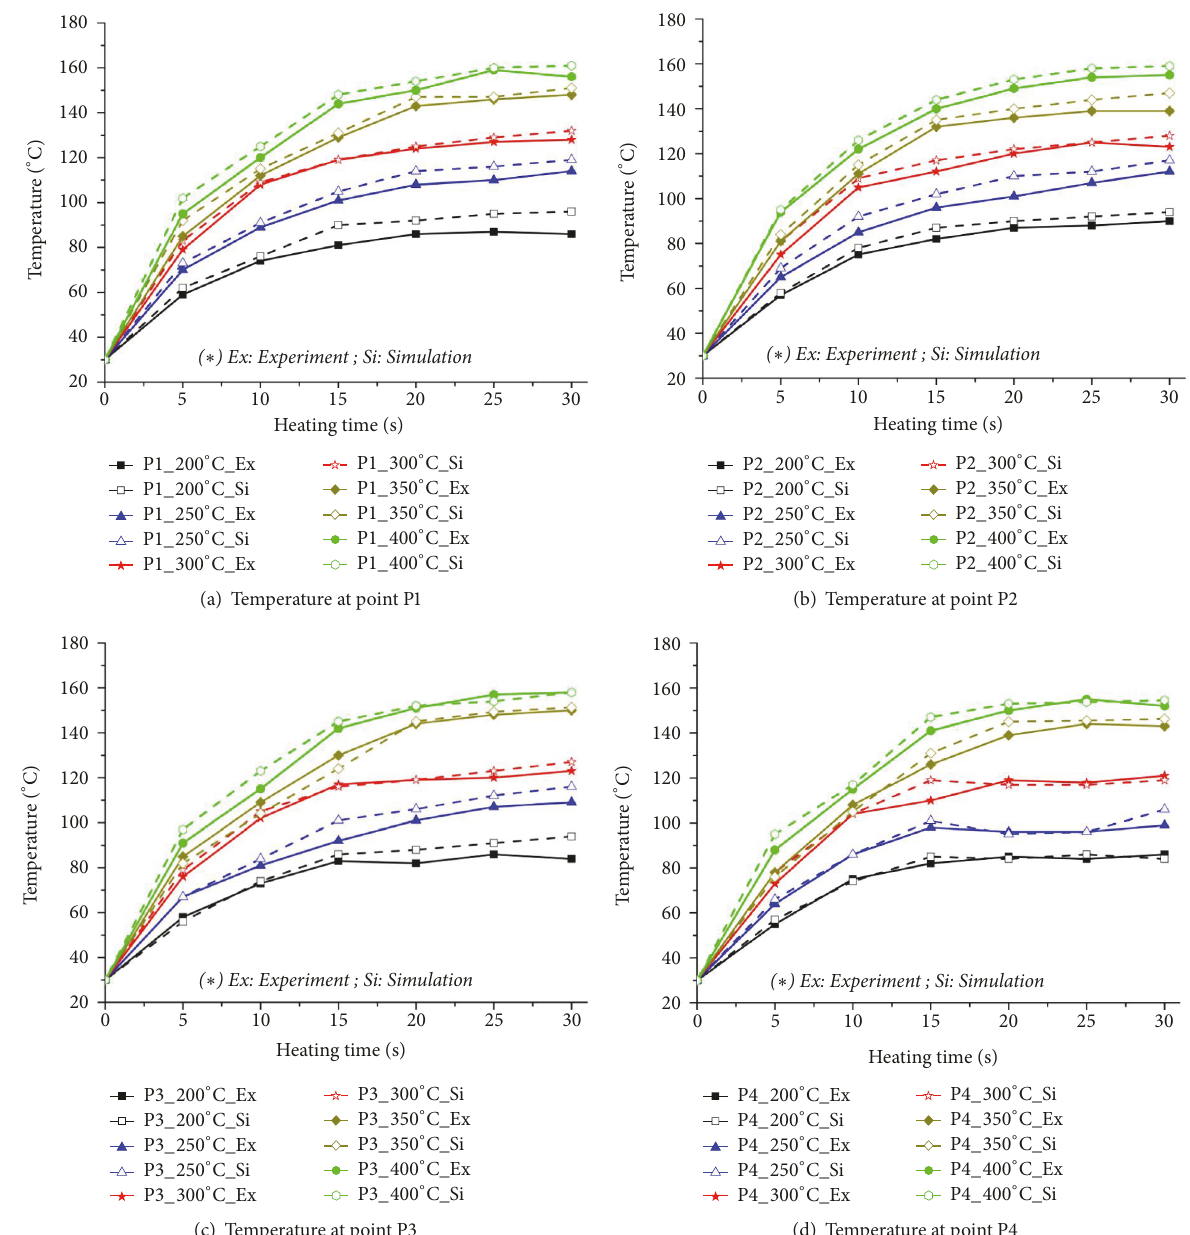
Figure 13: Temperature history at four points with different gas